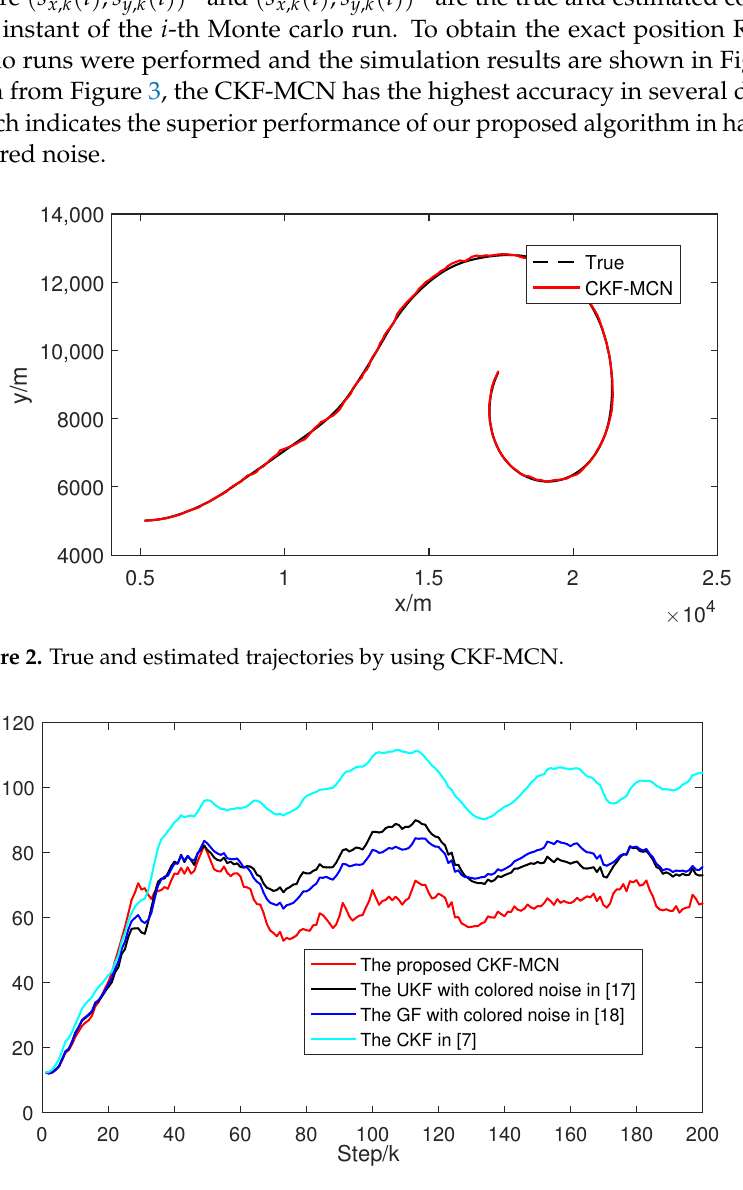
Figure 3. Comparisons of the position RMSE obtained by the proposed CKF-MCN, the UKF with colored noise in Ref. [17], the GF with colored noise in Ref. [18] and the CKF in Ref.